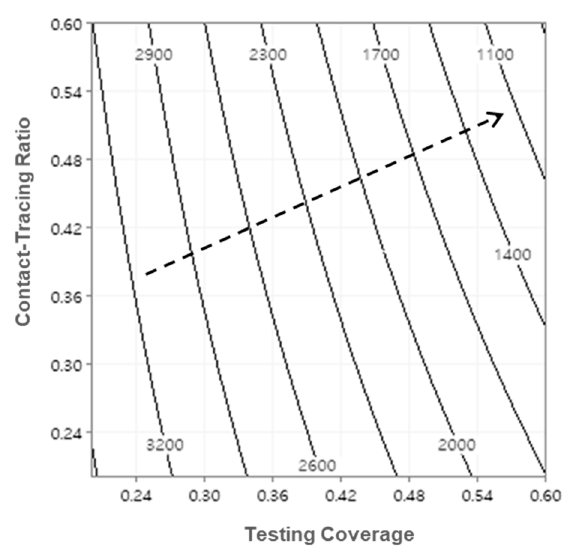
Figure 5. Contour plot of peak number of infections (turn-in time =